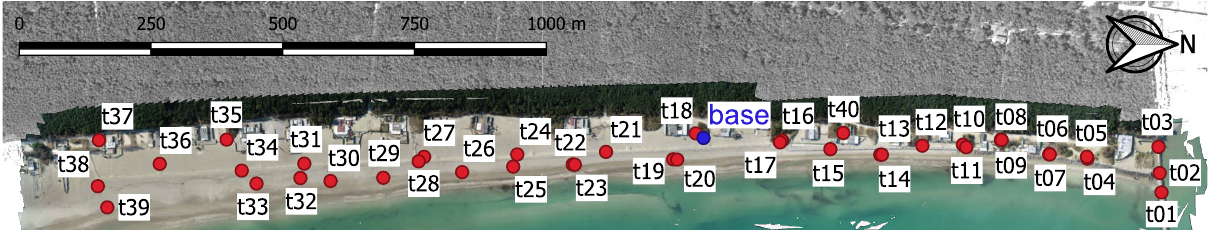
Figure 6. Ground Control Points (red) and base receiver (blue) locations. Table 3. Summary of the residuals for nadiral imageries with RTK camera coordinates and